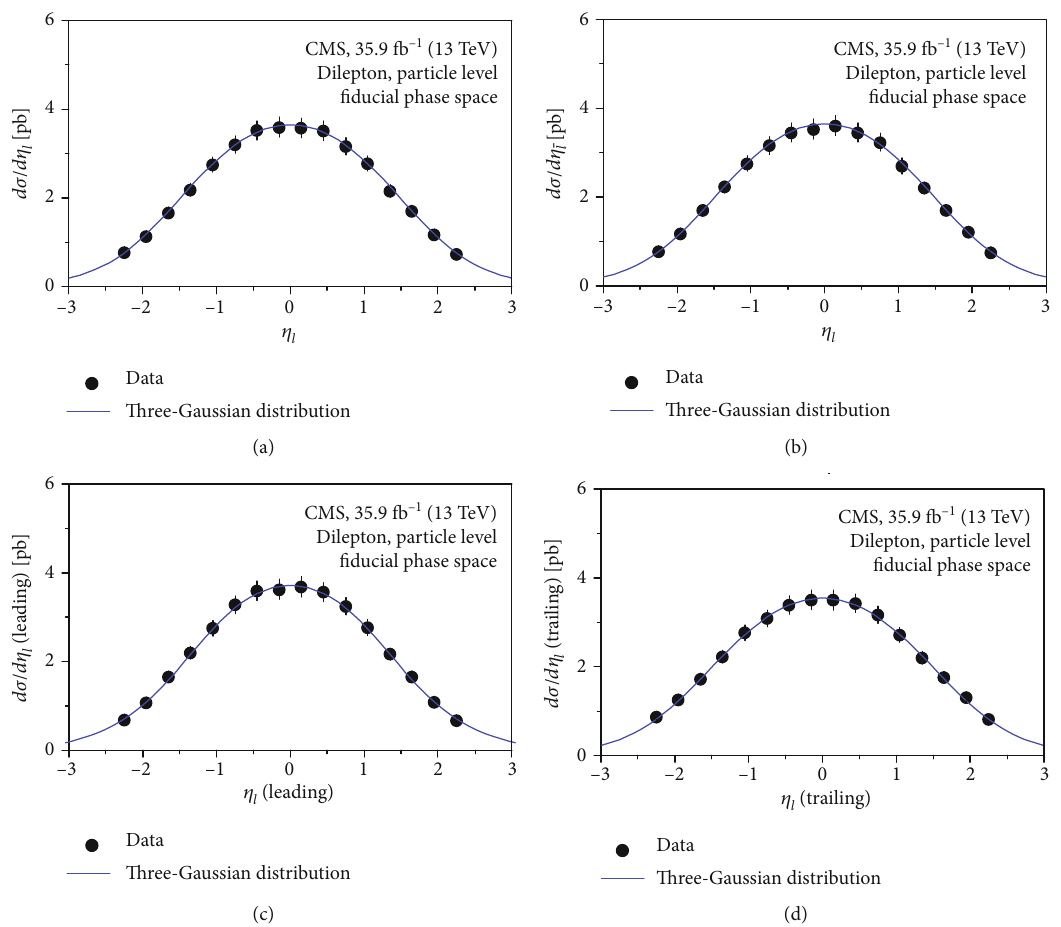
η (cid:1) l ), (b) the antilepton ( l ), (c) the